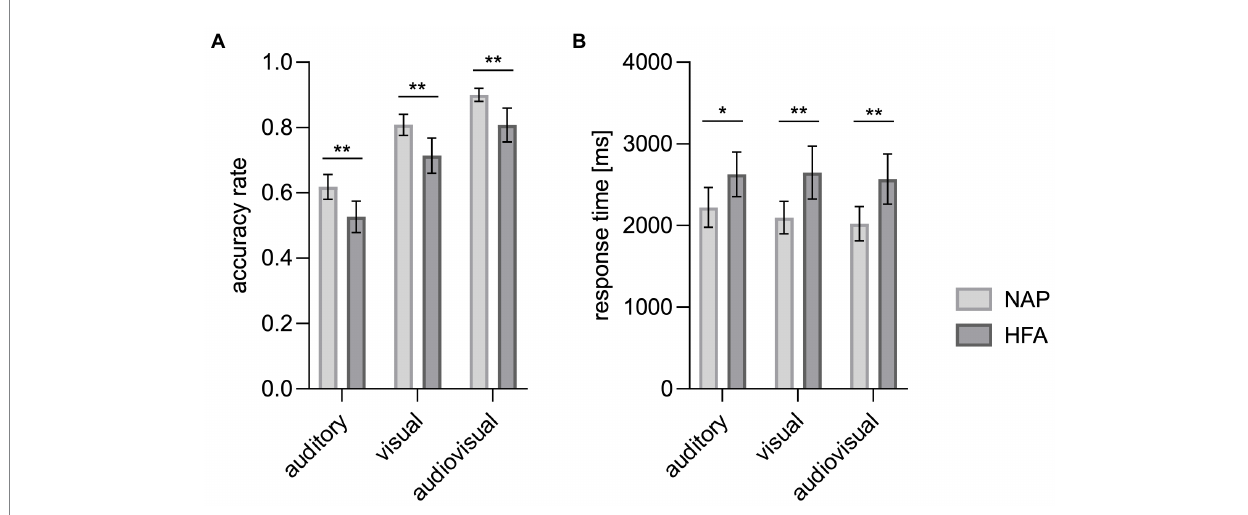
FIGURE 1 Mean accuracy rates (A) and mean response times (B) by modality. Significantly decreased accuracy rates and prolonged response times in autistic (HFA) as compared to non-autistic people (NAP) were observed for each of the three modalities. Error bars represent the corresponding 95%-CI. * p < 0.05. ** p <